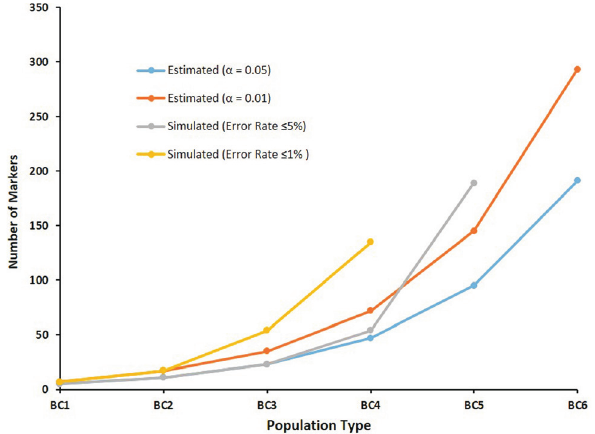
Figure 6 - Comparisons of estimated numbers of independent bi-allelic markers required to identify hybrid individuals in different intercross and backcross populations based on power analysis and observed error rates in simulated